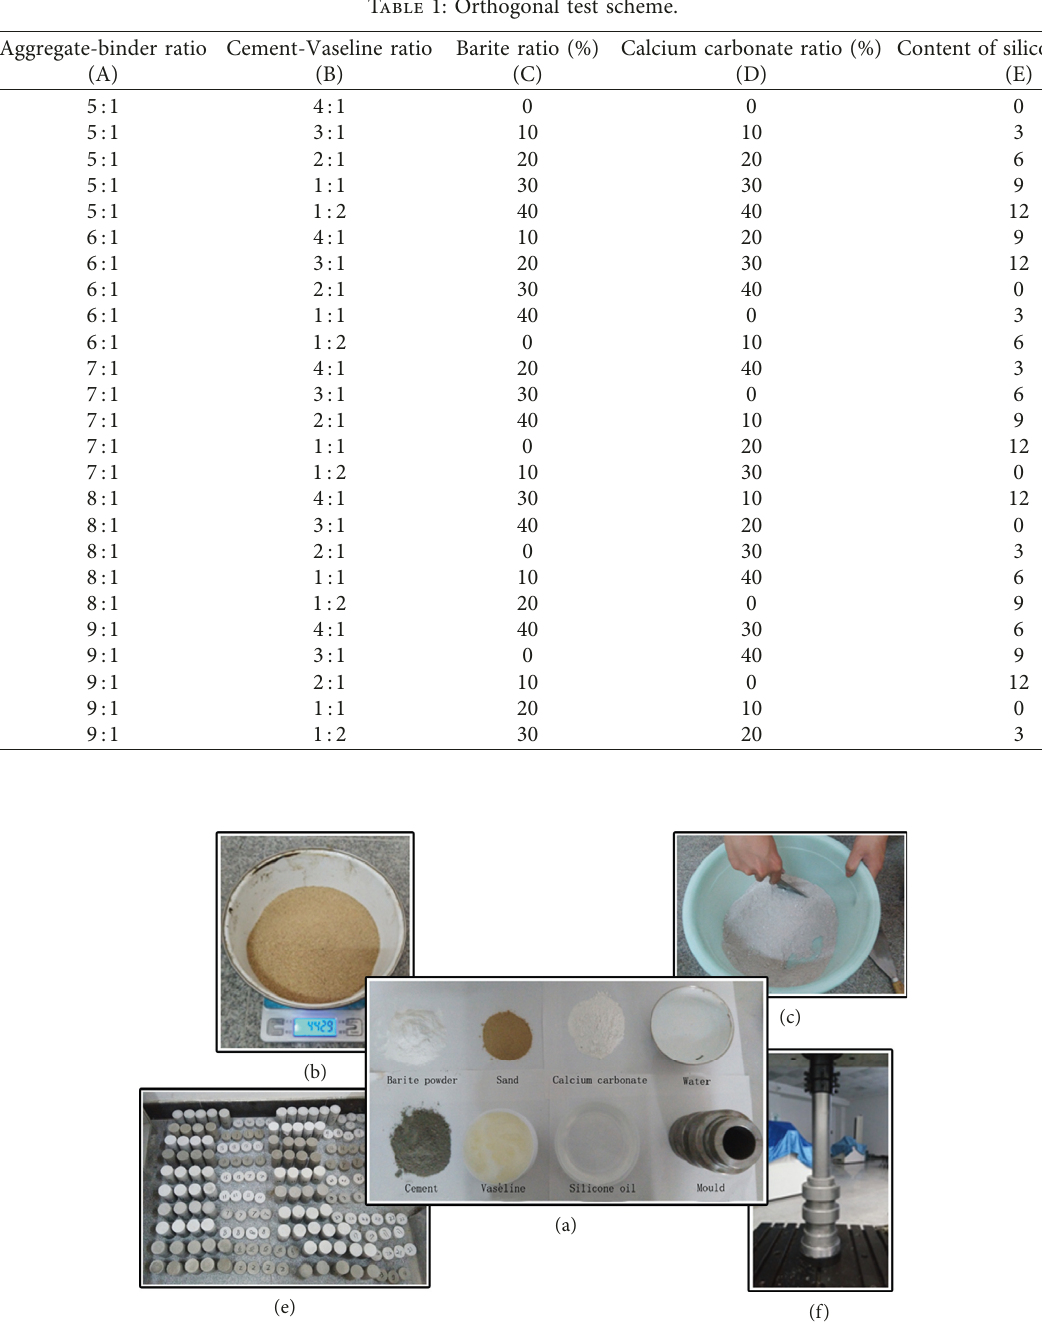
Figure 1: Original materials and production process. (a) Raw materials and mold. (b) Weighing. (c) Stirring. (d) Pressing molding. (e) Samples to be